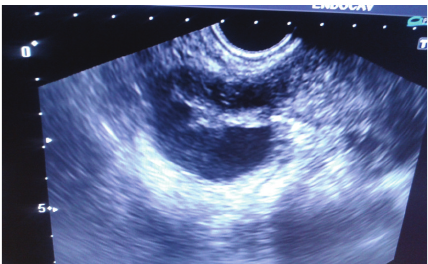
Figure 4: Ultrasound picture showing persistent tuboovarian masses.